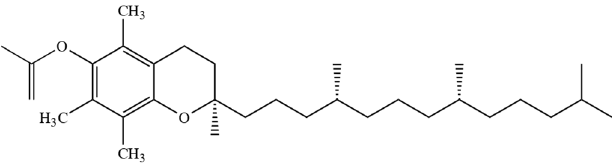
Figure 3. Chemical structure of α-tocopheryl acetate.